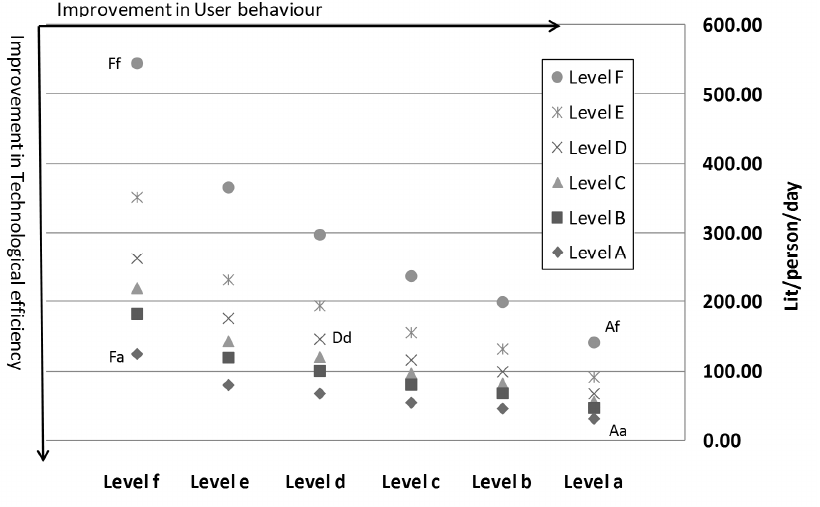
Figure 5. Domestic demands through behavioural and technological change (conventional